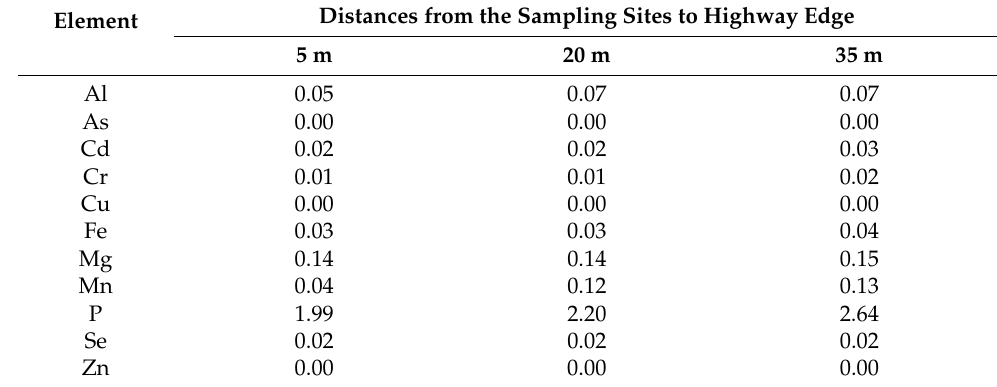
Table 4. Transfer factor of chemical elements in soils collected at three distances from the sampling sites from highway edge (D1, D2 and D3) to plant leaves.